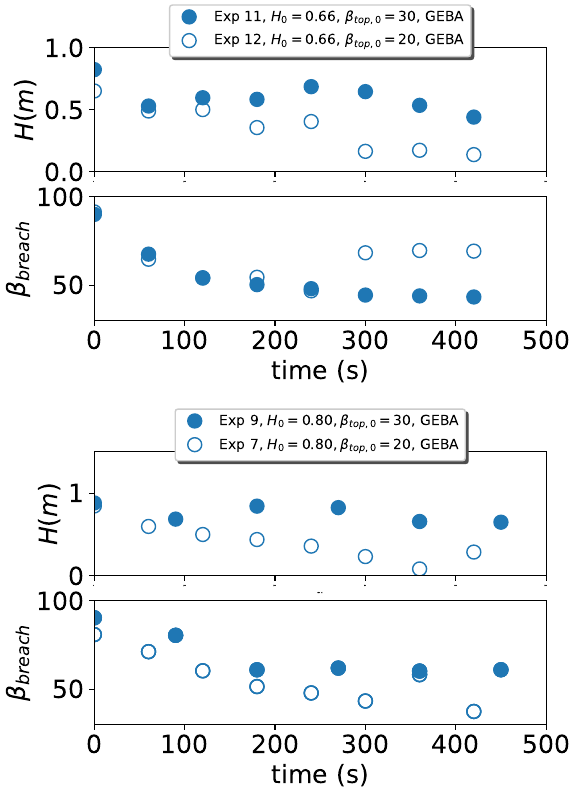
Figure 10. Effect of the initial angle of the slope at the top of the breach face, β top ,0 , on the temporal evolution of the breach height, H , and breach face angle, β breach